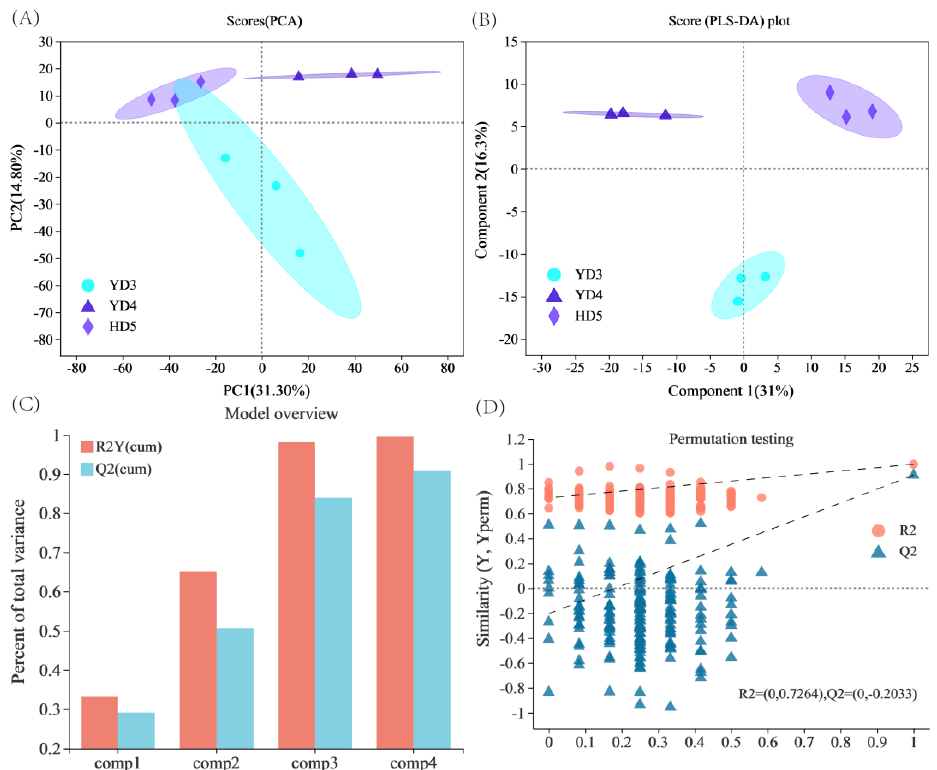
Figure 1 . Multivariate statistical score and permutation testing among the four rice varieties. ( A ) PCA. ( B ) PLS-DA. ( C ) Overview of the PLS-DA model. ( D ) PLS-DA permutation testing.